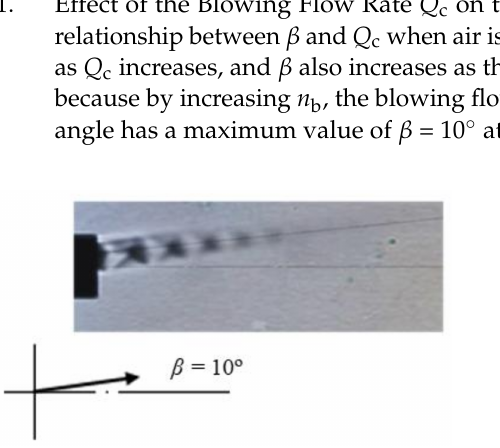
Figure 11. Deflection angle, β , of the 2-blow condition ( P 0 = 0.38 MPa, Q c = 10